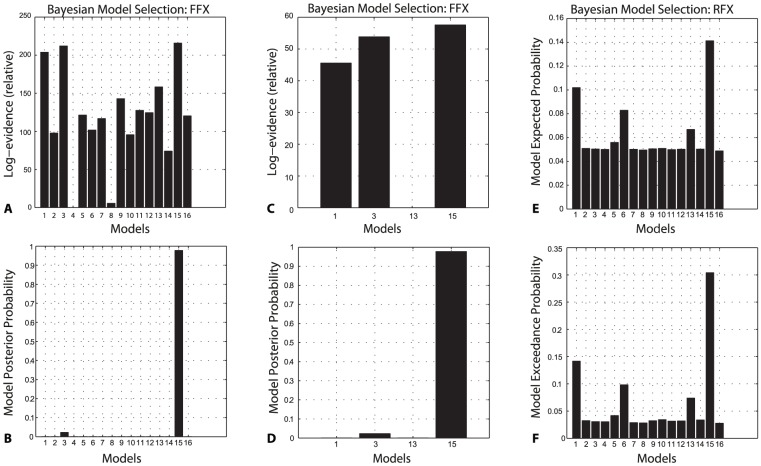
BMS results.FFX = Fixed Effects Assumptions, RFX = Random Effects Assumptions. (a) The relative log-evidences across all 16 specified models with model 3 showing the highest log-evidence. (b) Given the observed data and the models specified, one can be >95% certain that model 15 is the data generator. (c, d) The relative log-evidences between the 4 most likely models – again highlighting model 15 as the most likely model. This is repeated using RFX BMS, confirming the FFX findings (e, f).